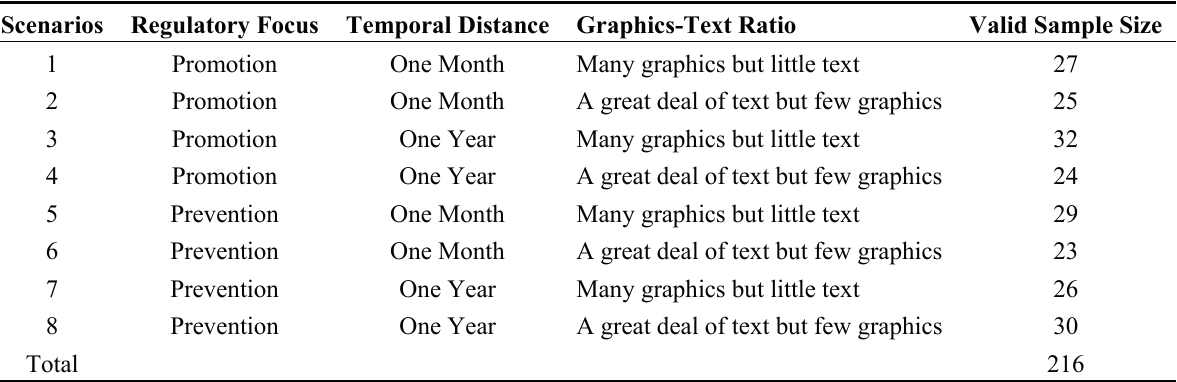
Table 1. Group size for each